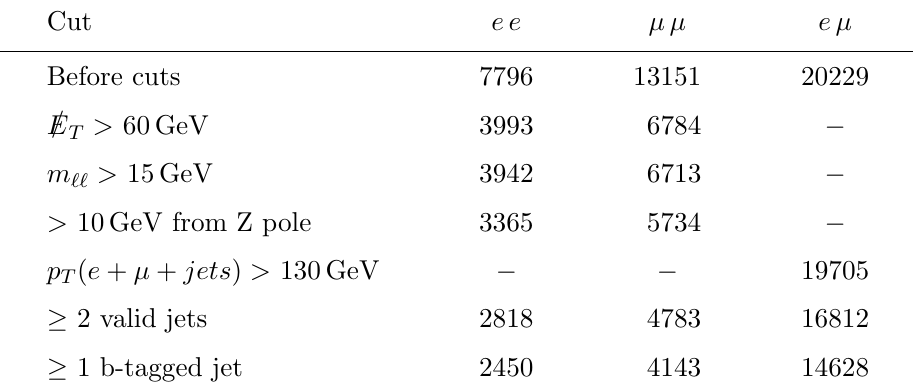
Table 3 . Cut-(cid:13)ow table for di-leptonic sample with m t = 172.5 GeV, separated by the (cid:13)avor of leptons in the (cid:12)nal state. The initial number of events is determined using the ATLAS integrated luminosity L = 20 : 2 fb (cid:0) 1 , and the production cross section is calculated using MadGraph5 aMC@NLO